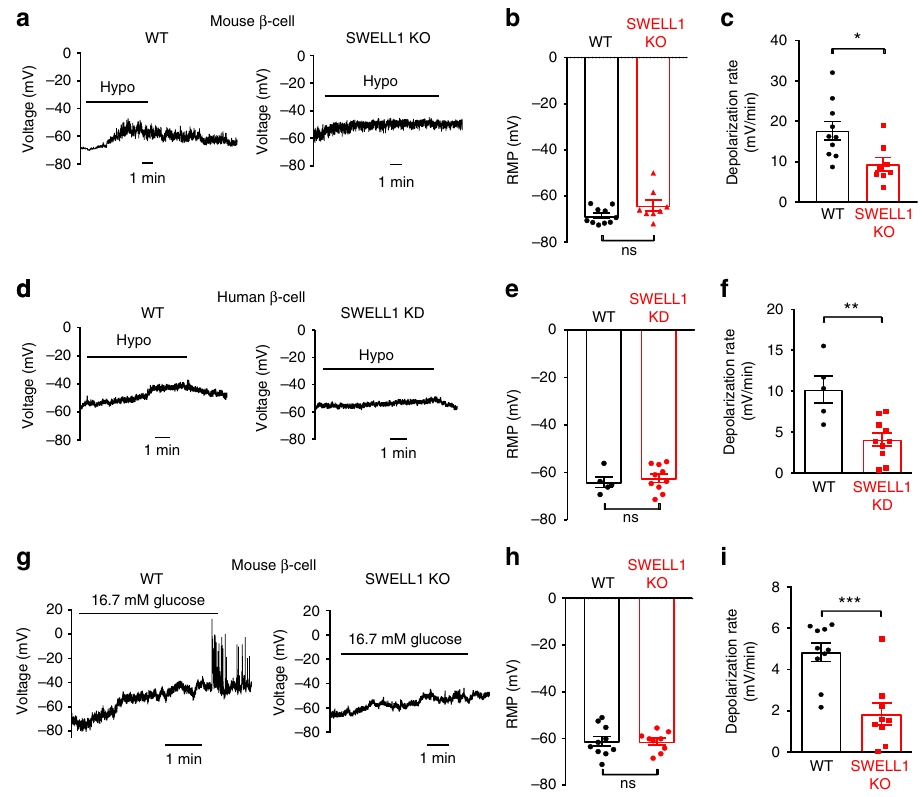
Fig. 3 SWELL1 depletion reduces swell- and glucose-stimulated β -cell membrane depolarization. a β -cell membrane potential measured in current-clamp mode upon application of hypotonic solution (210 mOsm/kg) in WT (left) and Swell1 KO (right) murine primary β -cells. b Resting membrane potential (RMP) and c membrane depolarization rate in WT ( n = 10) and Swell1 KO ( n = 8) murine primary β -cells in response to hypotonic swelling. d β -cell membrane potential measured in current-clamp mode upon application of hypotonic solution (210 mOsm/kg) in WT (left) and SWELL1 KD (right) human primary β -cells. e RMP and f membrane depolarization rate in WT ( n = 5) and SWELL1 KD ( n = 10) human primary β -cells in response to hypotonic swelling. g Glucose (16.7 mM)-elicited membrane depolarization in isolated WT (left) and Swell1 KO murine β -cells. h RMP and i membrane depolarization rate in WT ( n = 10) and Swell1 KO ( n = 9) murine primary β -cells in response to 16.7 mM glucose stimulation from 1 mM basal glucose. All of the recordings above were performed at 35 – 37 °C in perforated patch con fi guration, current-clamp mode. Data are shown as mean ± s.e.m. * p < 0.05; ** p < 0.01; *** p < 0.001, unpaired t -test. ns, not signi fi